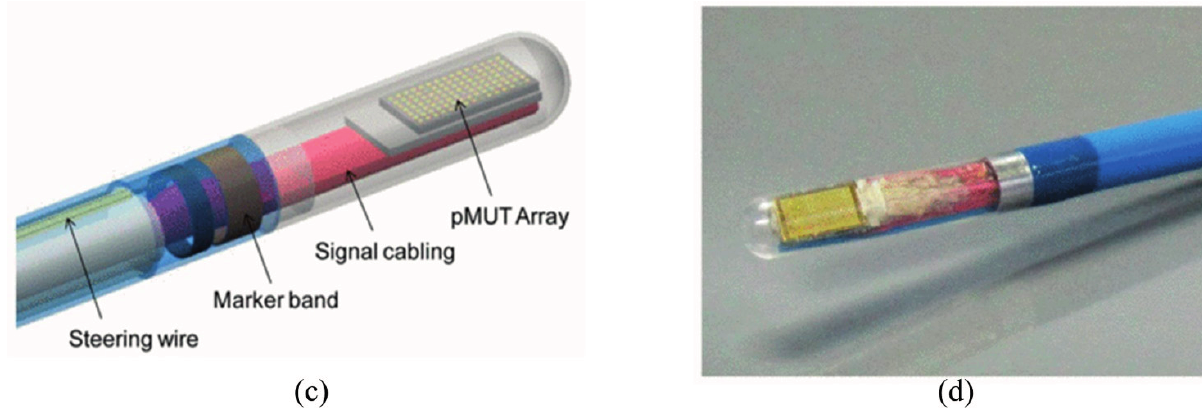
Figure 14. Cross-sectional schematic diagrams of ( a ) PMUTs with through-Si interconnects and ( b ) a PMUT array substrate bonded onto a wiring substrate; ( c ) a mechanical model and ( d ) photograph of the distal end of a steerable 14-Fr (Ø4.667 mm) ICE catheter containing a 512-element PMUT matrix array. © 2013 IEEE. Reprinted with permission from